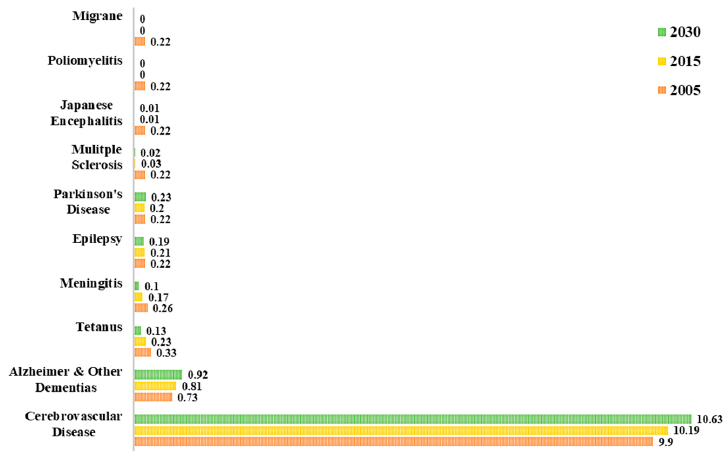
Figure 2. Percentage of total death attributable to neurological disorders in 2005, 2015 and 2030 [3].